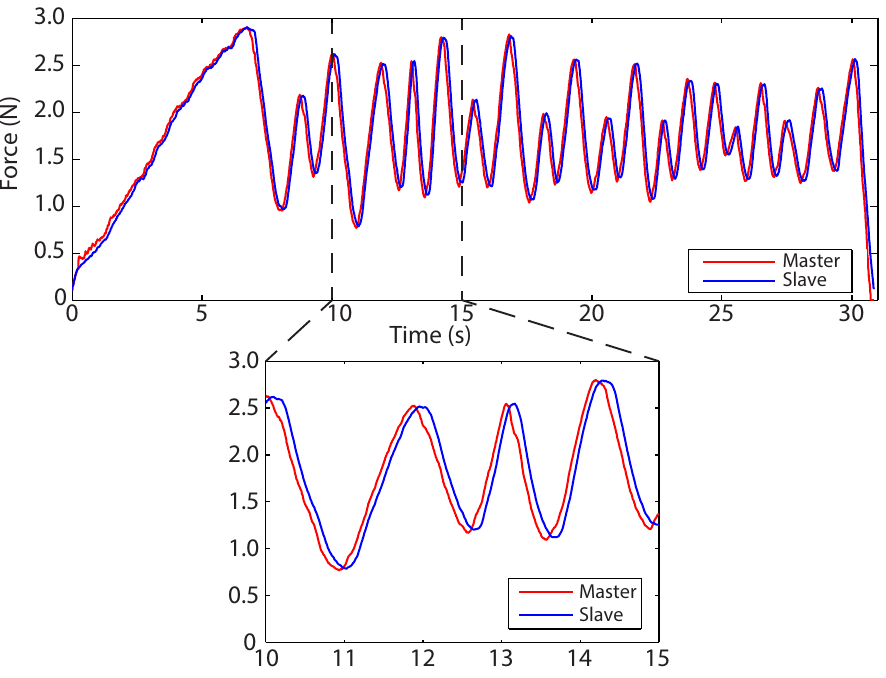
Figure 9. Force–time profiles of the slave and master, using the original spring-based adaptor, with a section highlighting the adaptor acting on the master feedback force.